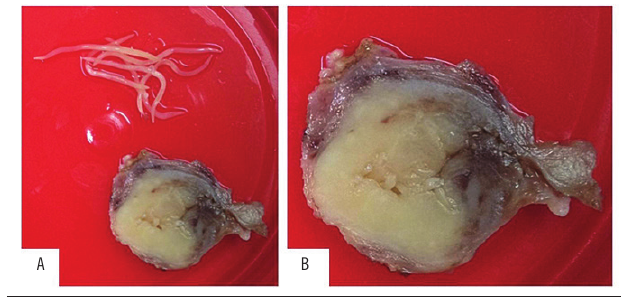
A figurE 1 − Cervical lymph nodes and adult worms A) cervical lymph node containing cylindrical worms measuring on average 1.5 cm in length each; B) detail of the lymph node containing the worms.